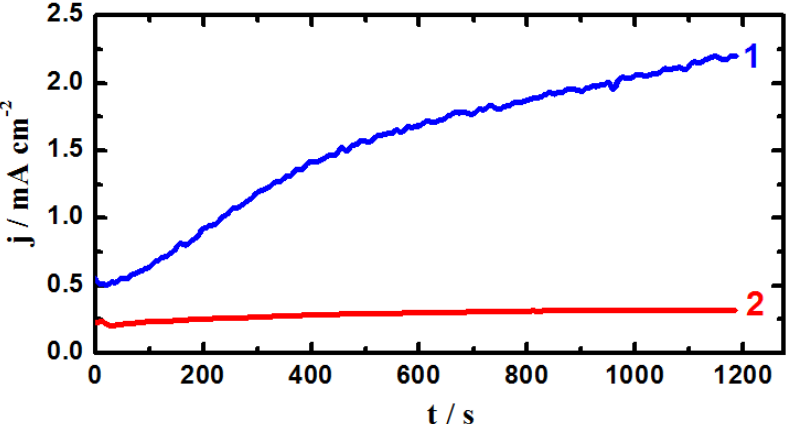
Figure 4. Chronoamperometric current-time curves obtained at − 0.350 V vs. Ag/AgCl